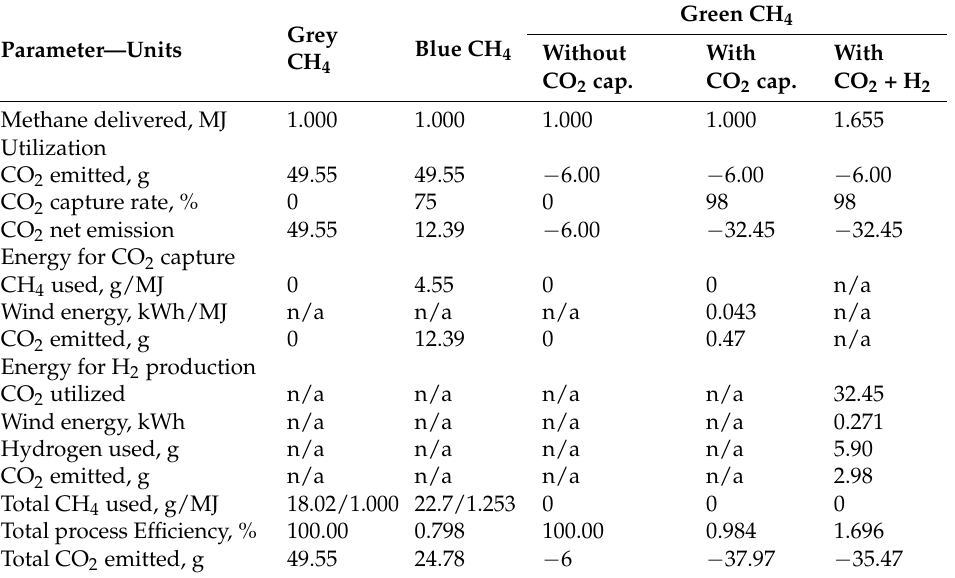
Table 2. Energy use and carbon dioxide emissions from the utilization/production of one megajoule of either grey methane or blue methane or green methane without biogas carbon dioxide capture, green methane with biogas carbon dioxide capture and green methane with biogas carbon dioxide utilization along with green hydrogen to generate more green